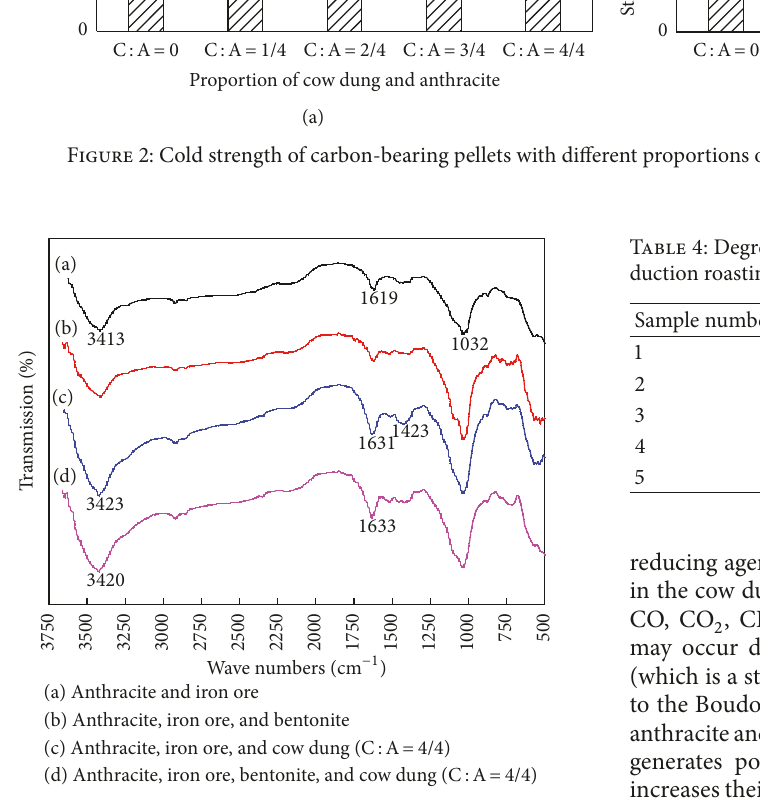
Figure 3: FTIR spectra of carbon-bearing pellets, comparing differ- ent raw materials.